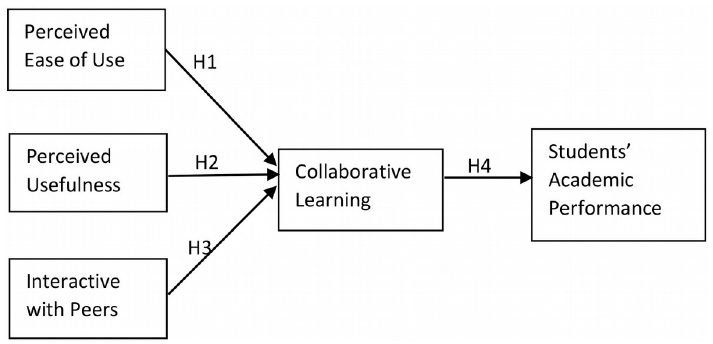
Figure 2. Proposed conceptual